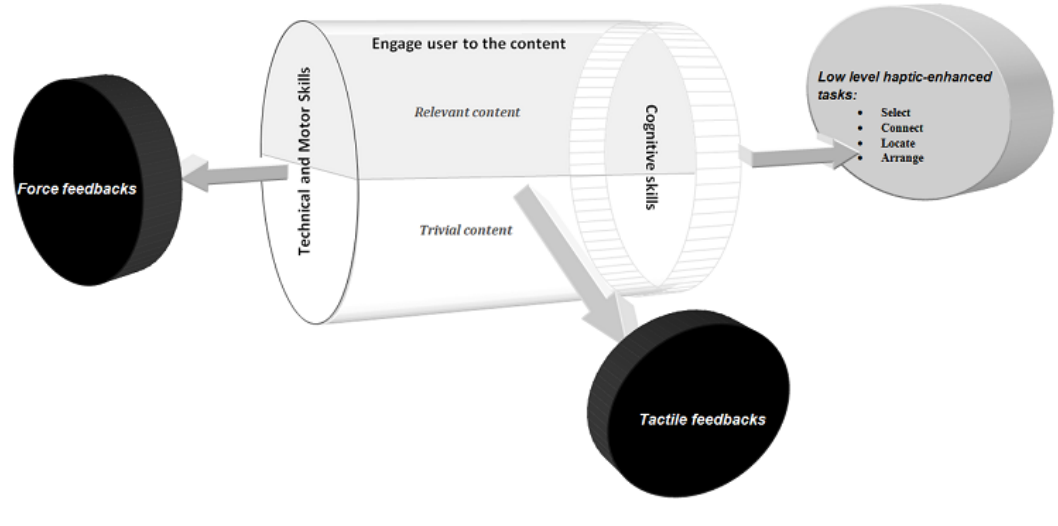
Figure 2. The model proposed to use the haptic modality to support learning outcomes in Serious Games